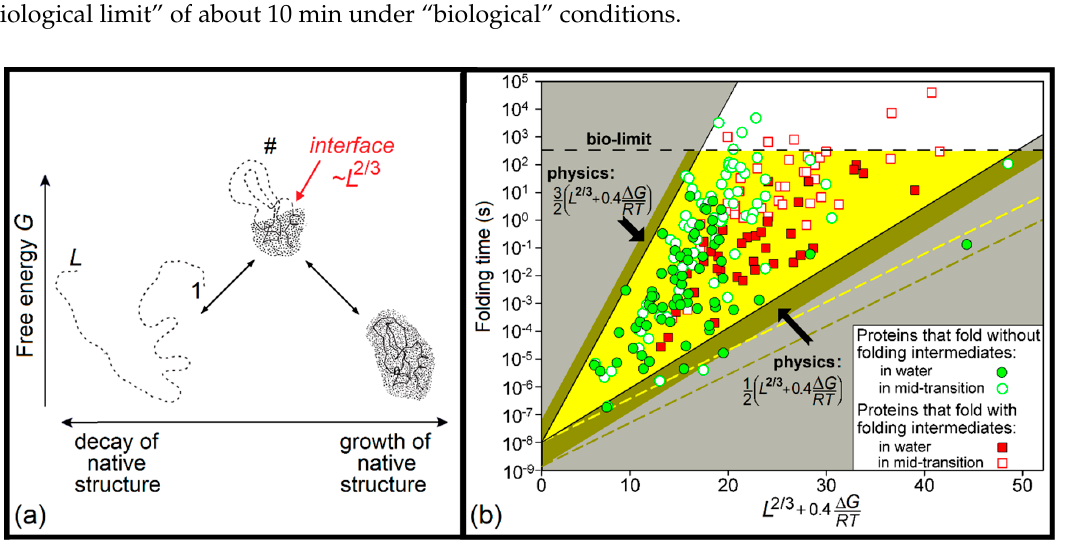
Figure 3. ( a ) The free energy diagram for the folding of a globular domain. Unfolded (left), native (right), and transition state (middle, #) structures are given. The dashed line denotes the unfolded phase, while the dotted body denotes the native phase. ( b ) Experimentally measured in vitro folding times at mid-transition and at “biological” (“in water”) conditions (or close to them) for 107 proteins. The bright triangular region defines the folding times at the mid-transition point outlined by physical theory (Equation (2)). If we additionally draw the biological limit line (“bio-limit”) corresponding to ~10 min, we get a “golden” triangle reflecting the physical and biological restrictions for the protein folding times at the mid-transition point. Two additional bronze areas join the “golden” triangle if we also consider physiological conditions. Two extra dashed lines define the mid-transition (yellow) and in-water (bronze) boundaries for proteins with more elongated or oblate native structures (axis ratio 2:1 or 1:2). L denotes the number of amino acid residues in a protein. ∆ G is the free energy difference between the native and unfolded states of the protein for particular (“in water” or “mid-transition”) conditions. Adapted from [11] with some modifications.